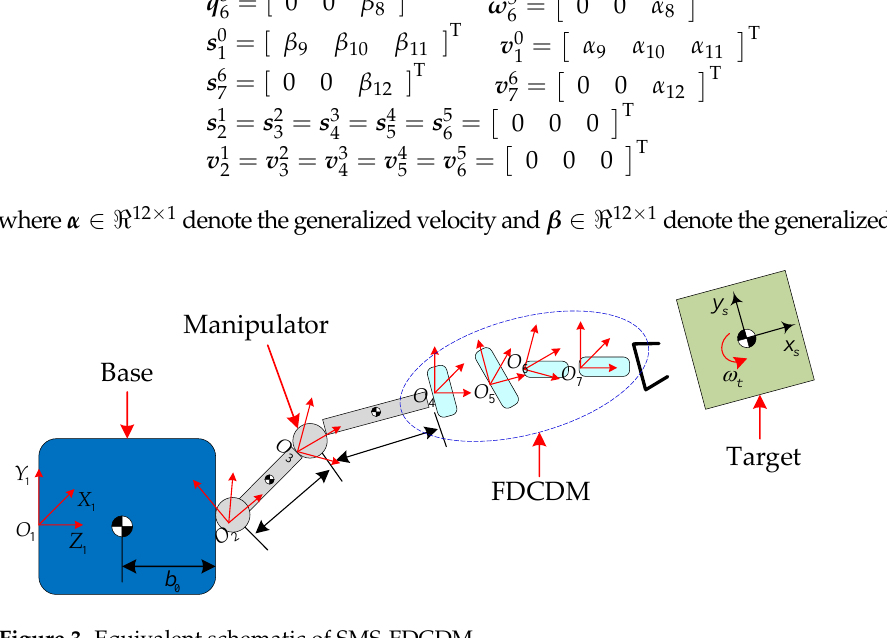
Figure 3. Equivalent schematic of SMS-FDCDM. Then, we can obtain the relative rotation matrix of the proprio-coordinate system in